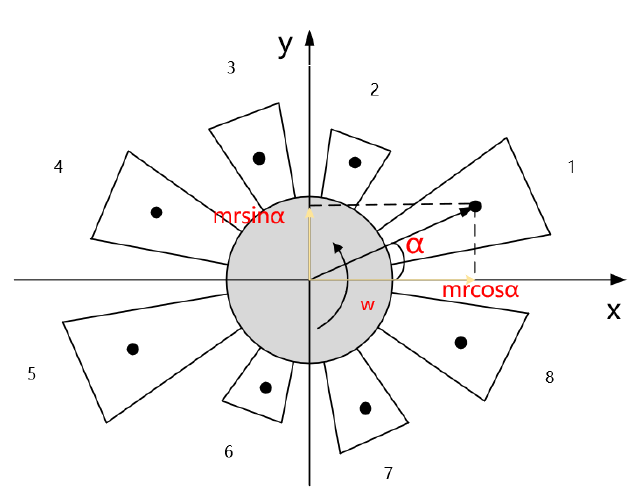
Figure 4. Blade mass moment orthogonal decomposition.